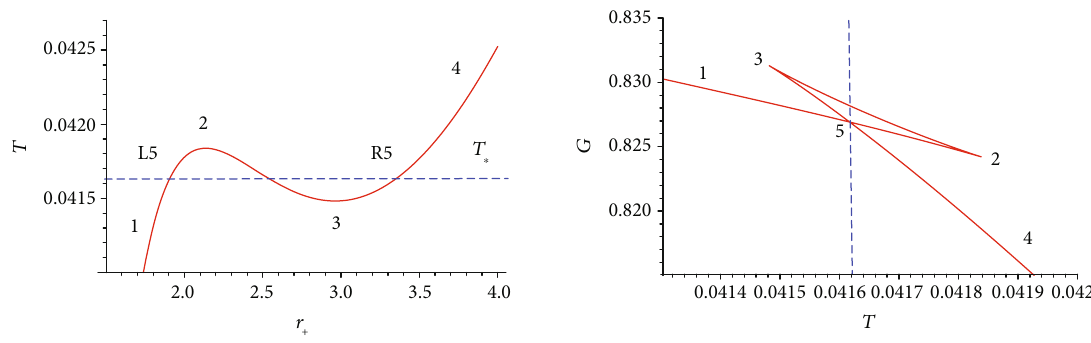
− T diagrams of four-dimensional AdS black holes with ψ = − 5/2 , N Figure 4: The T − r + and G